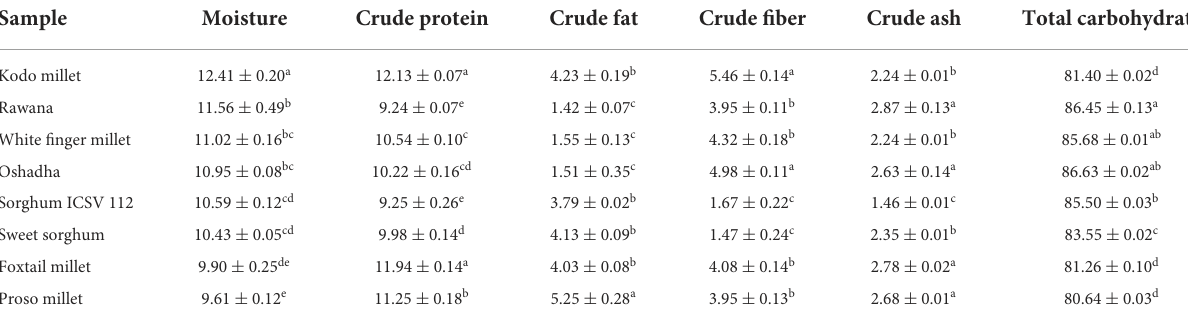
TABLE 1 Proximate composition of the selected millet types and sorghum